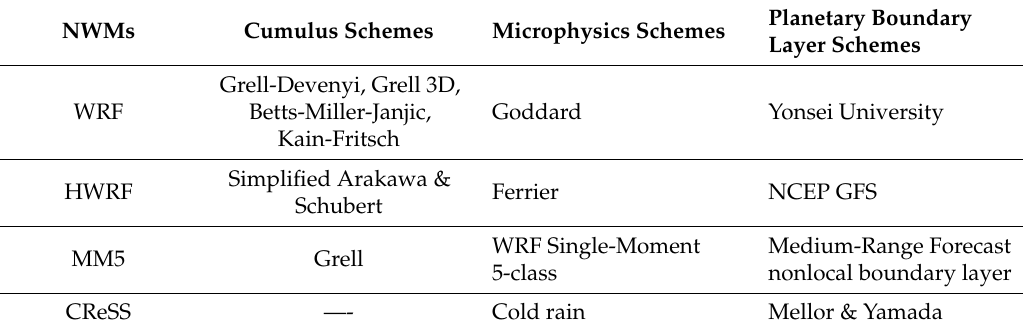
Table 1. Physical parameterization schemes of Taiwan Typhoon and Flood Research Institute (TTFRI)-ensemble prediction system (EPS) ensemble members.